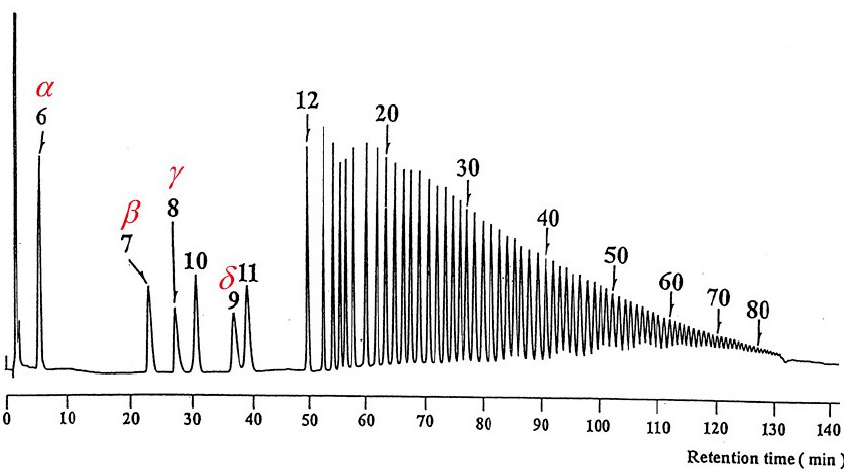
Figure 26. Separation of cyclodextrin congeners (CD6–CD85) enzymatically obtained by cyclodextrin glycosyltransferase from Bacillus macerans on synthetic amylose by high-performance anion-exchange chromatography (HPAEC) with pulsed amperometric detection using a 25 cm × 4 mm I.D. Dionex CarboPac PA-100 column. Reprinted with permission from [108].